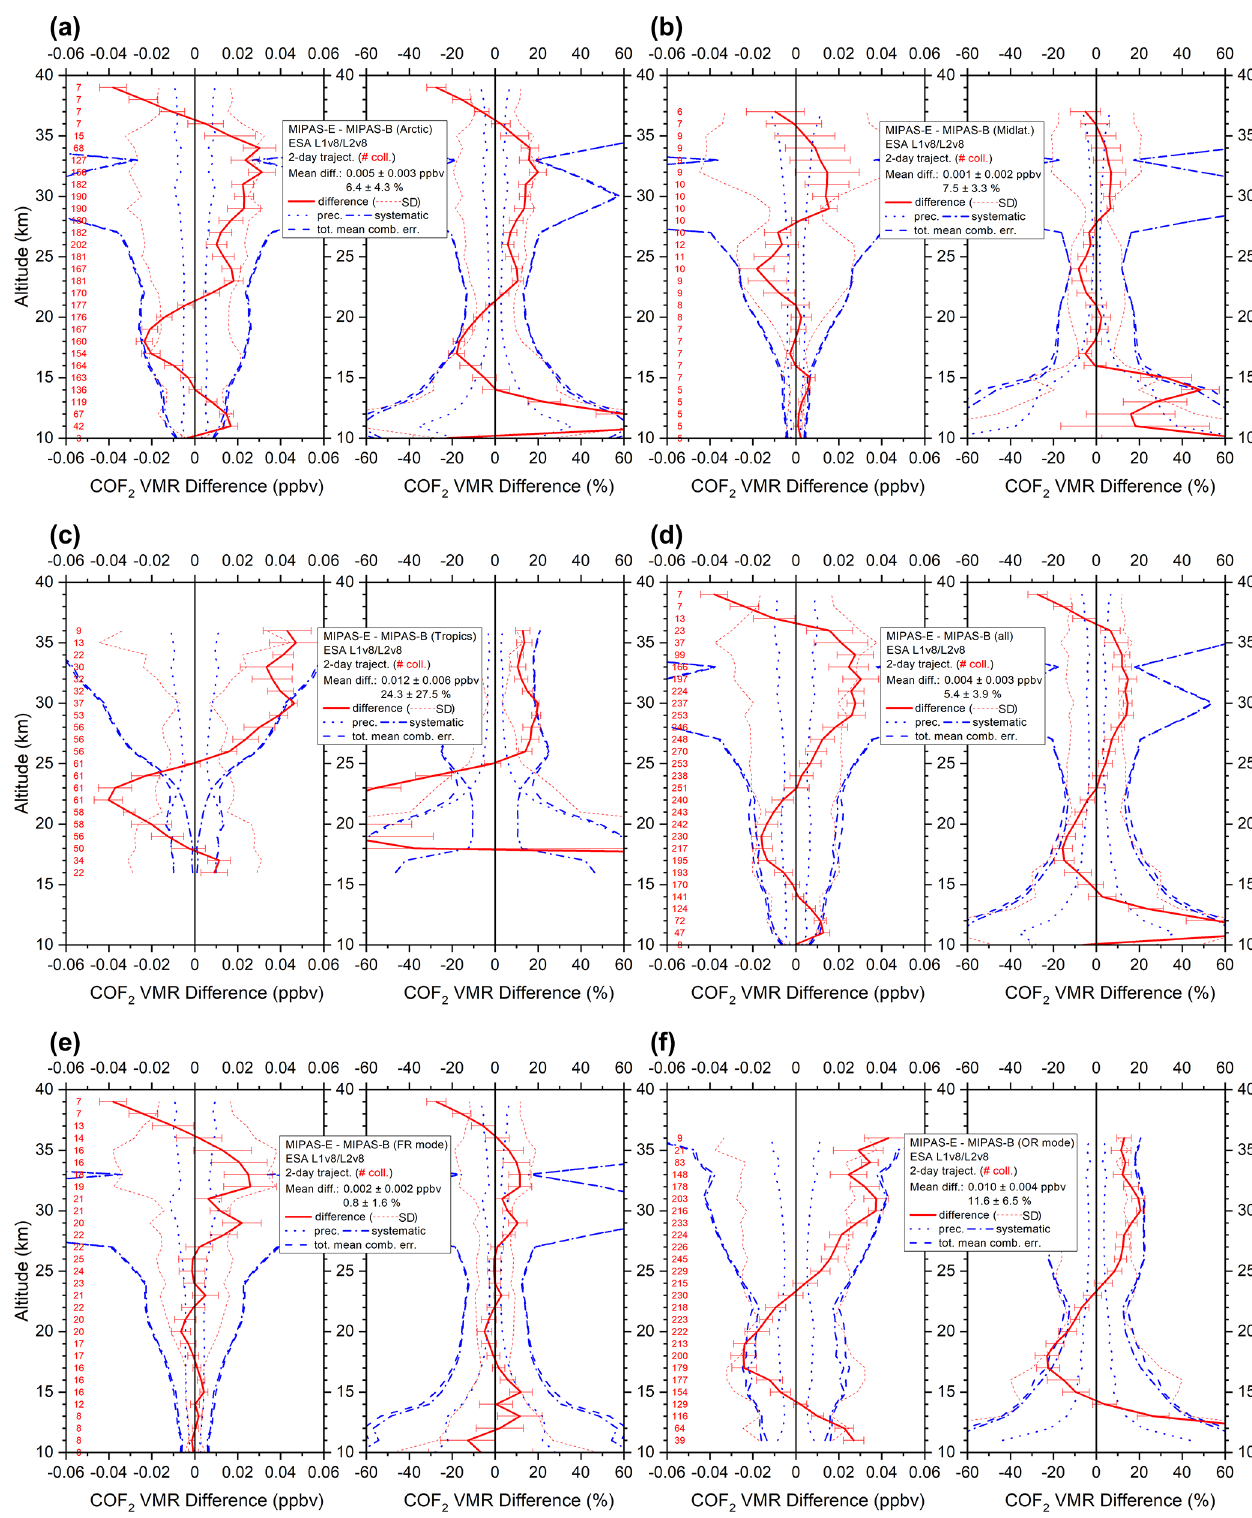
Figure 16. Same as Fig. 3 but for COF 2